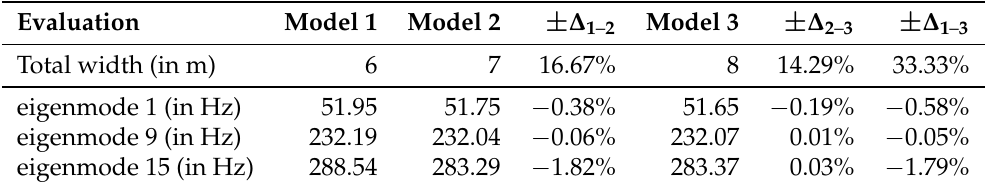
Figure 16. Influence of surrounding concrete. Table 6. Concrete influence study.